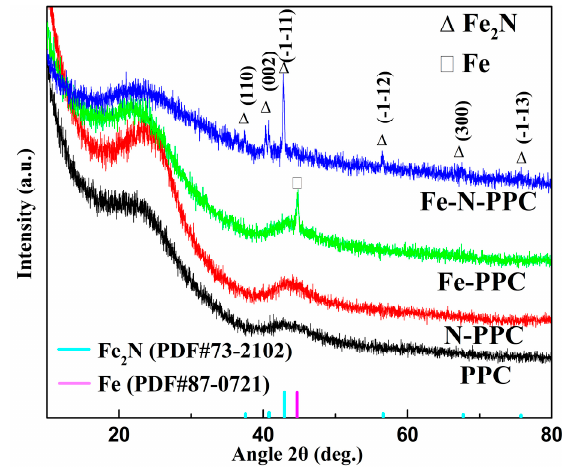
Figure 1. X-ray diffraction (XRD) patterns of PPC, N-PPC, Fe-PPC, and Fe-N-PPC carbonized at 900 °C.